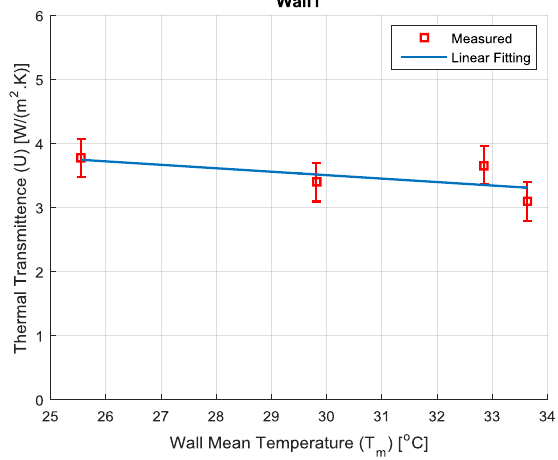
Figure 8. Thermal transmittance of Wall System 1 as a function of the wall mean temperature.